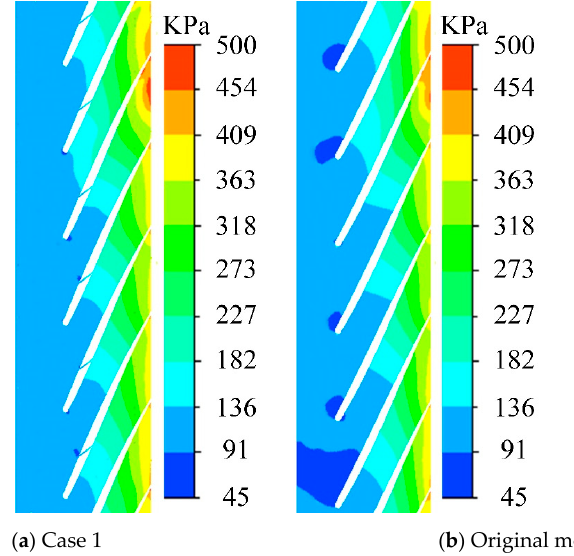
Figure 11. Static pressure distributions on the cross section of the impeller channel at 0.6 Q.